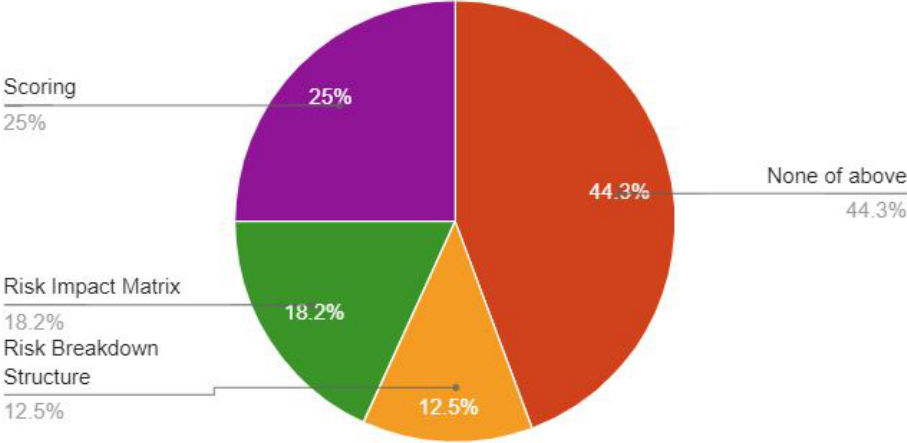
Figure 7. Methods for calculating risk